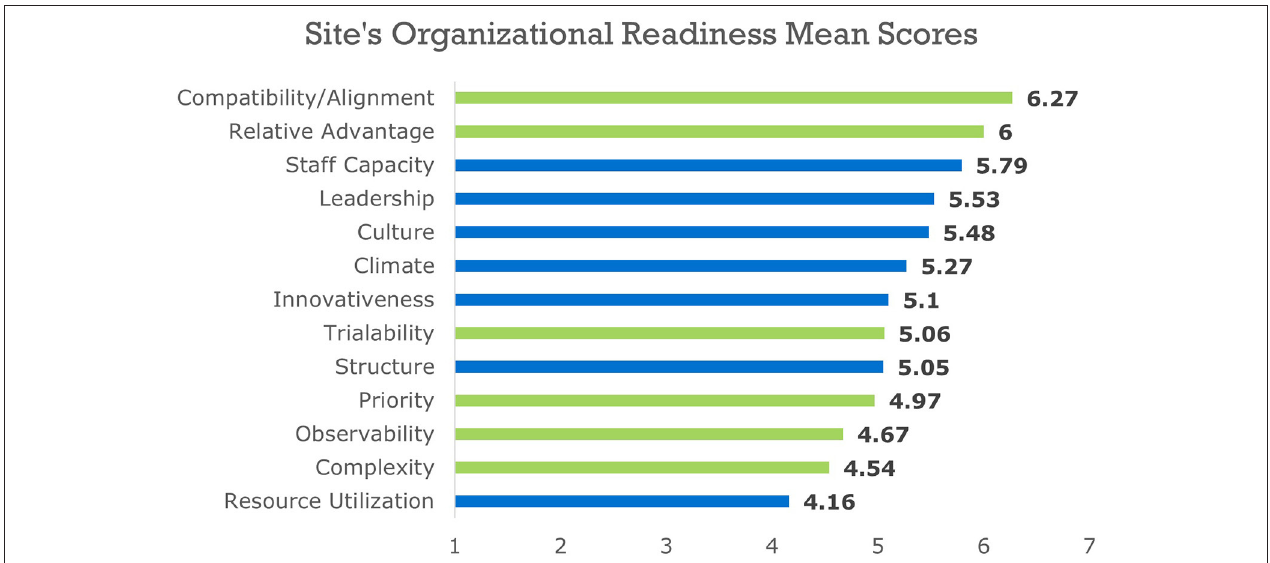
FIGURE 4 | De-identified organizational readiness mean scores. Green bars are motivation subcomponents, blue bars are general capacity